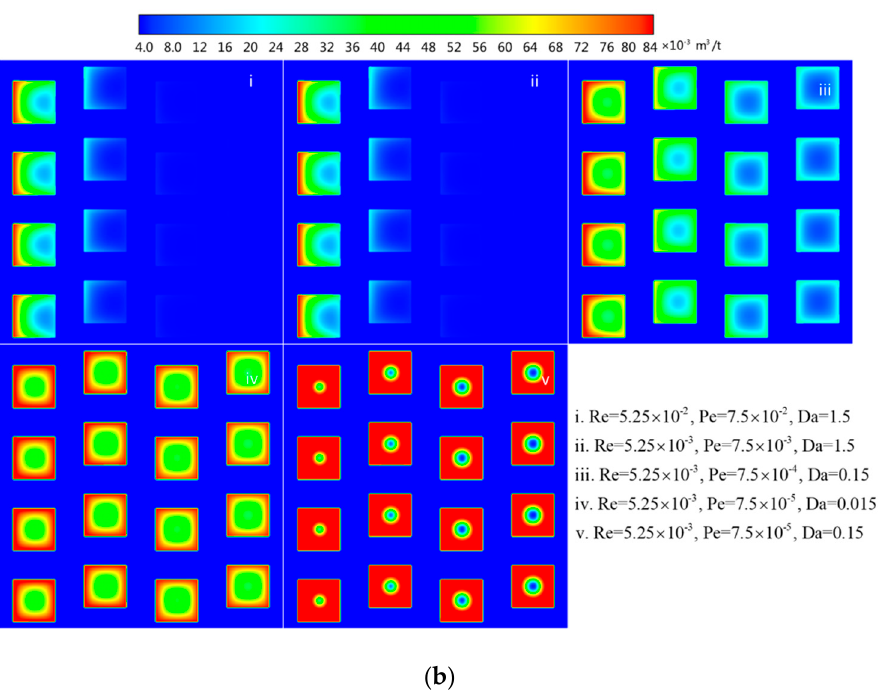
Figure 5. Concentration and adsorbed amount magnitude distribution. ( a ) Gas concentration distribution and ( b ) adsorbed amount distribution.